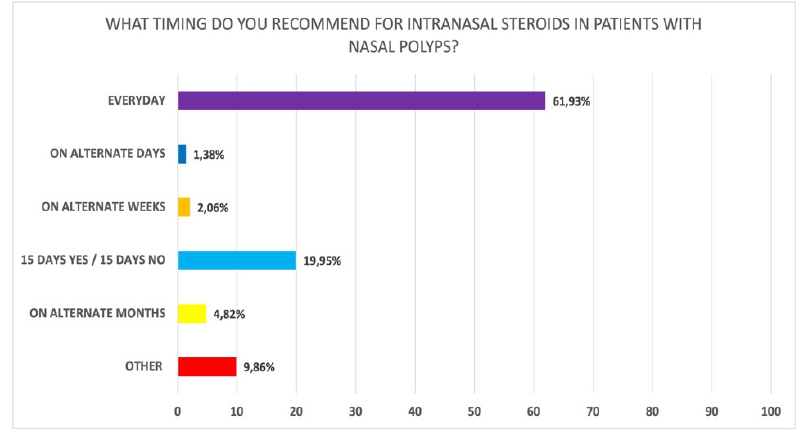
Figure 1. Recommended frequency of prescription of local corticosteroids in patients with CRSwNP (Q5 of Supplementary Materials File).